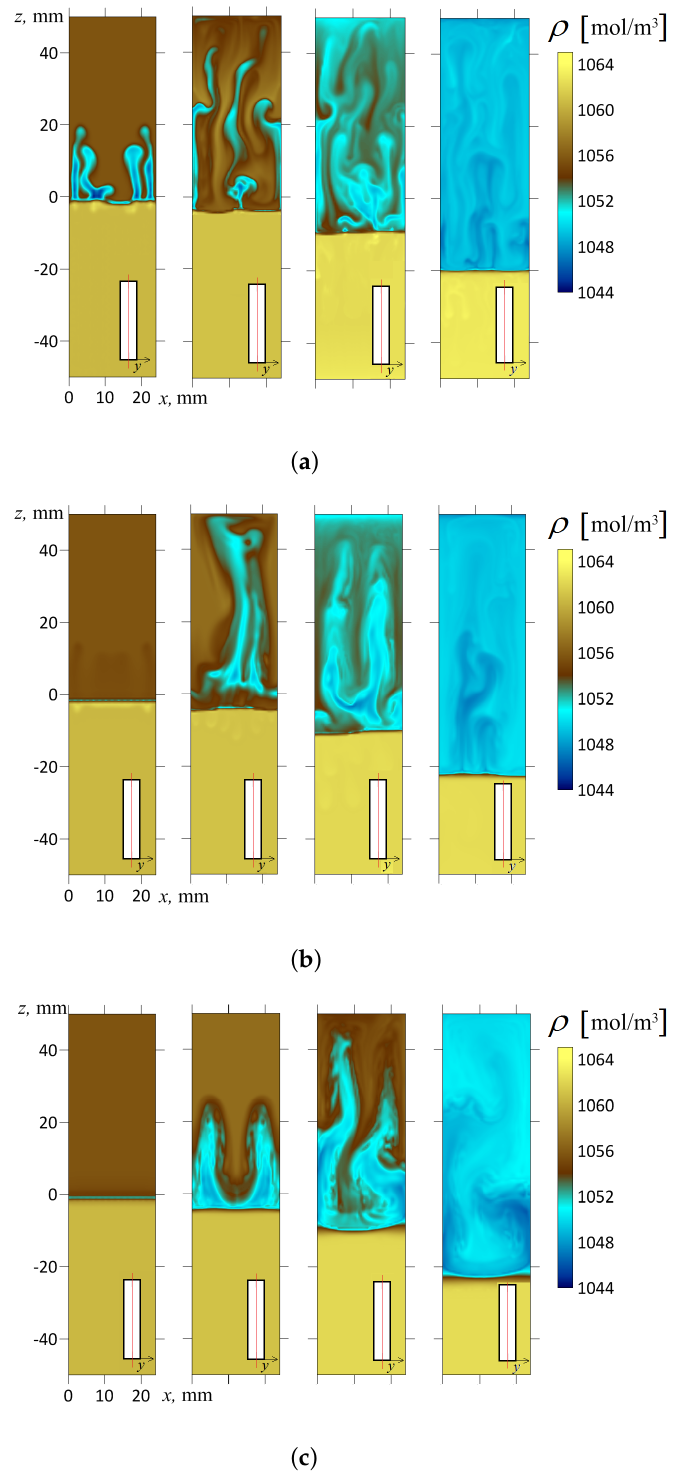
Figure 10. The density fields calculated for the inclination angles α = 0 ◦ ( a ); α = 30 ◦ ( b ); α = 70 ◦ ( c ). The frames of each series from left to right correspond to the successive times y = 10 s; 50 s; 150 s; 600 s, respectively. A contrast color palette was used to reveal the fine structure of the density fields. All fields are represented in the longitudinal section of the slot by plane y = 0.6 mm, which divides the volume exactly into halves. The red line in the inset indicates the cross-section of the slot where the concentration distribution is